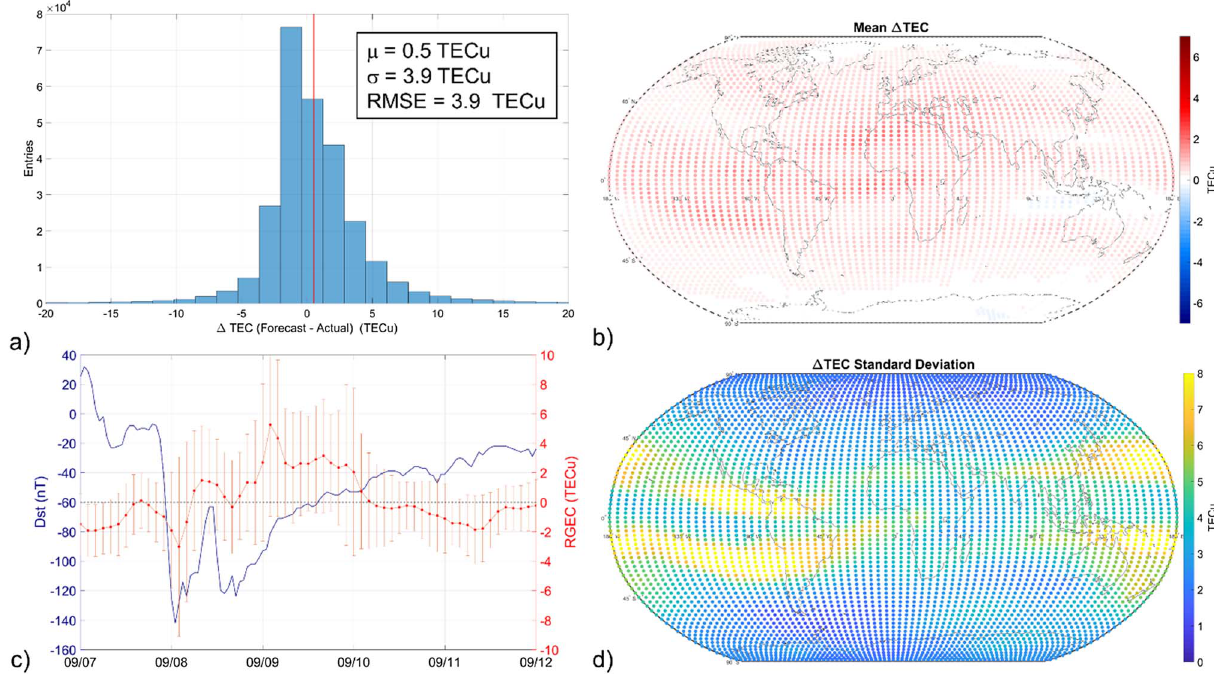
Fig. 11. Same as Figure 9 considering the “ frozen ionosphere ” assumption.